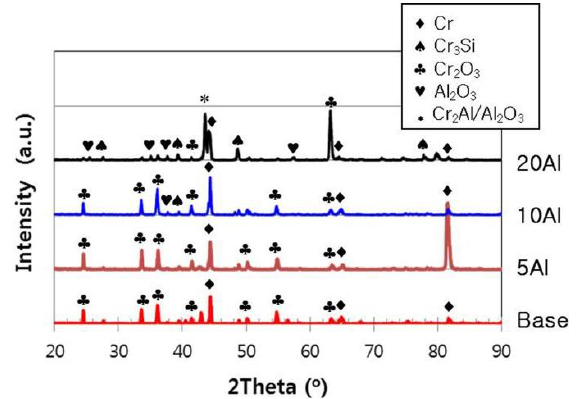
Figure 7. Oxidation behavior of Cr–xAl–5%Si alloys during the isothermal heating at 1100 °C.